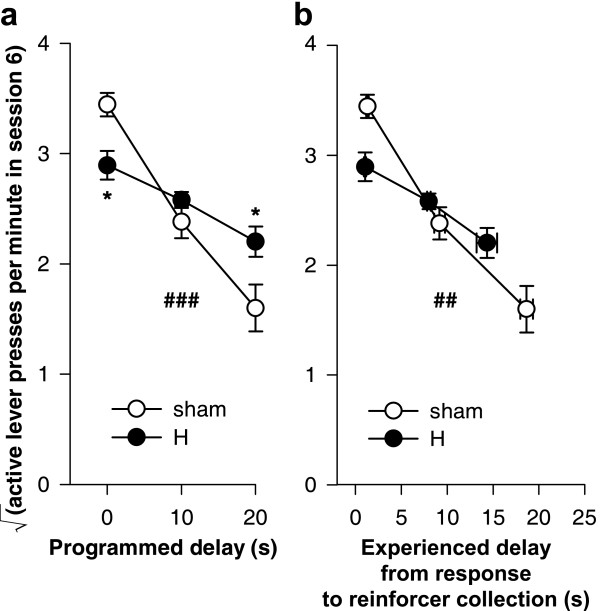
Learning as a function of programmed and experienced delays to reinforcement. The imposition of response-reinforcer delays systematically retarded the acquisition of free-operant instrumental responding, but this effect was lessened in H-lesioned rats, even allowing for differences in experienced response-collection delays. (a) The rate of lever-pressing in session 6 is plotted against the programmed response-reinforcer delay. There was a lesion × delay interaction (### p = .001): H-lesioned rats responded less than shams at zero delay (* p = .015), were not significantly different from shams at 10 s delay (p = .197), and responded more than shams at 20 s (* p = .028). (b) Responding in session 6 plotted against the experienced response-to-reinforcer collection delays for sessions 1–6 (vertical error bars: SEM of the square-root-transformed number of responses in session 6; horizontal error bars: SEM of the experienced response-collection delay, calculated up to and including that session). The gradients of the two lines differed significantly (## p = .002; see text), indicating that the relationship between experienced delays and responding was altered in H-lesioned rats.